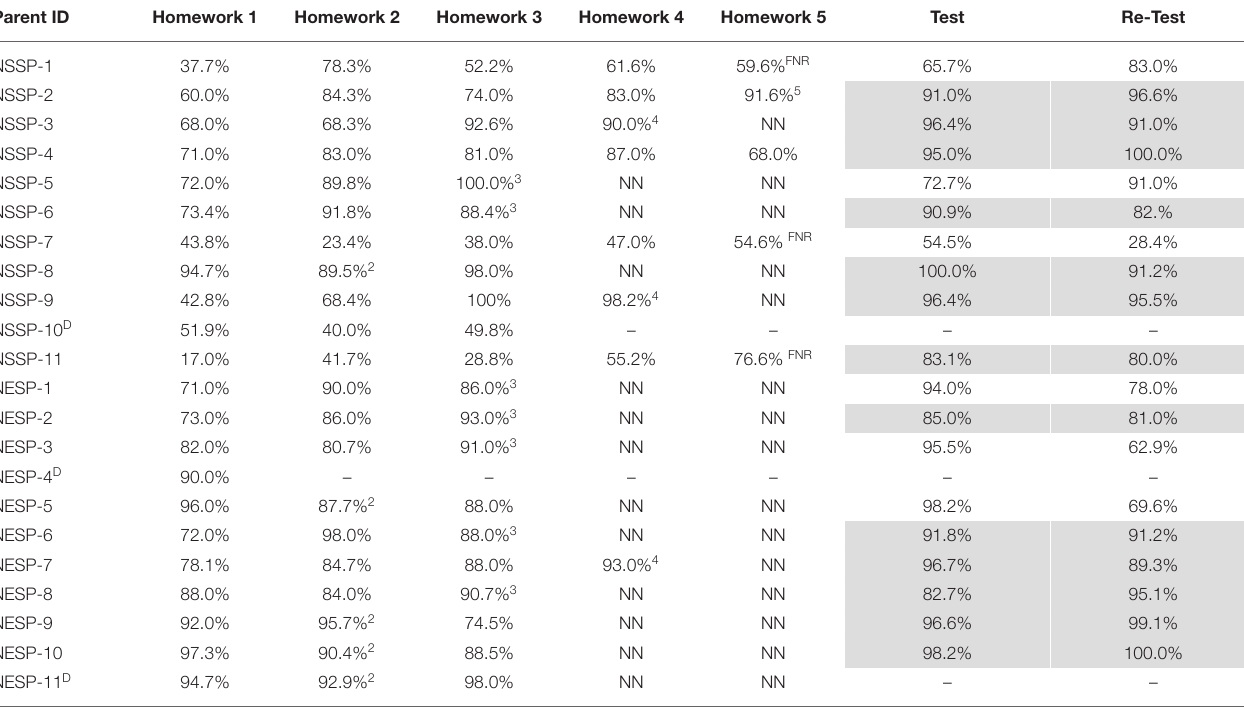
TABLE 4 | Percent of fidelity scoring rubric (FSR) elements scored correct in each session for the 22 parents who participated in the